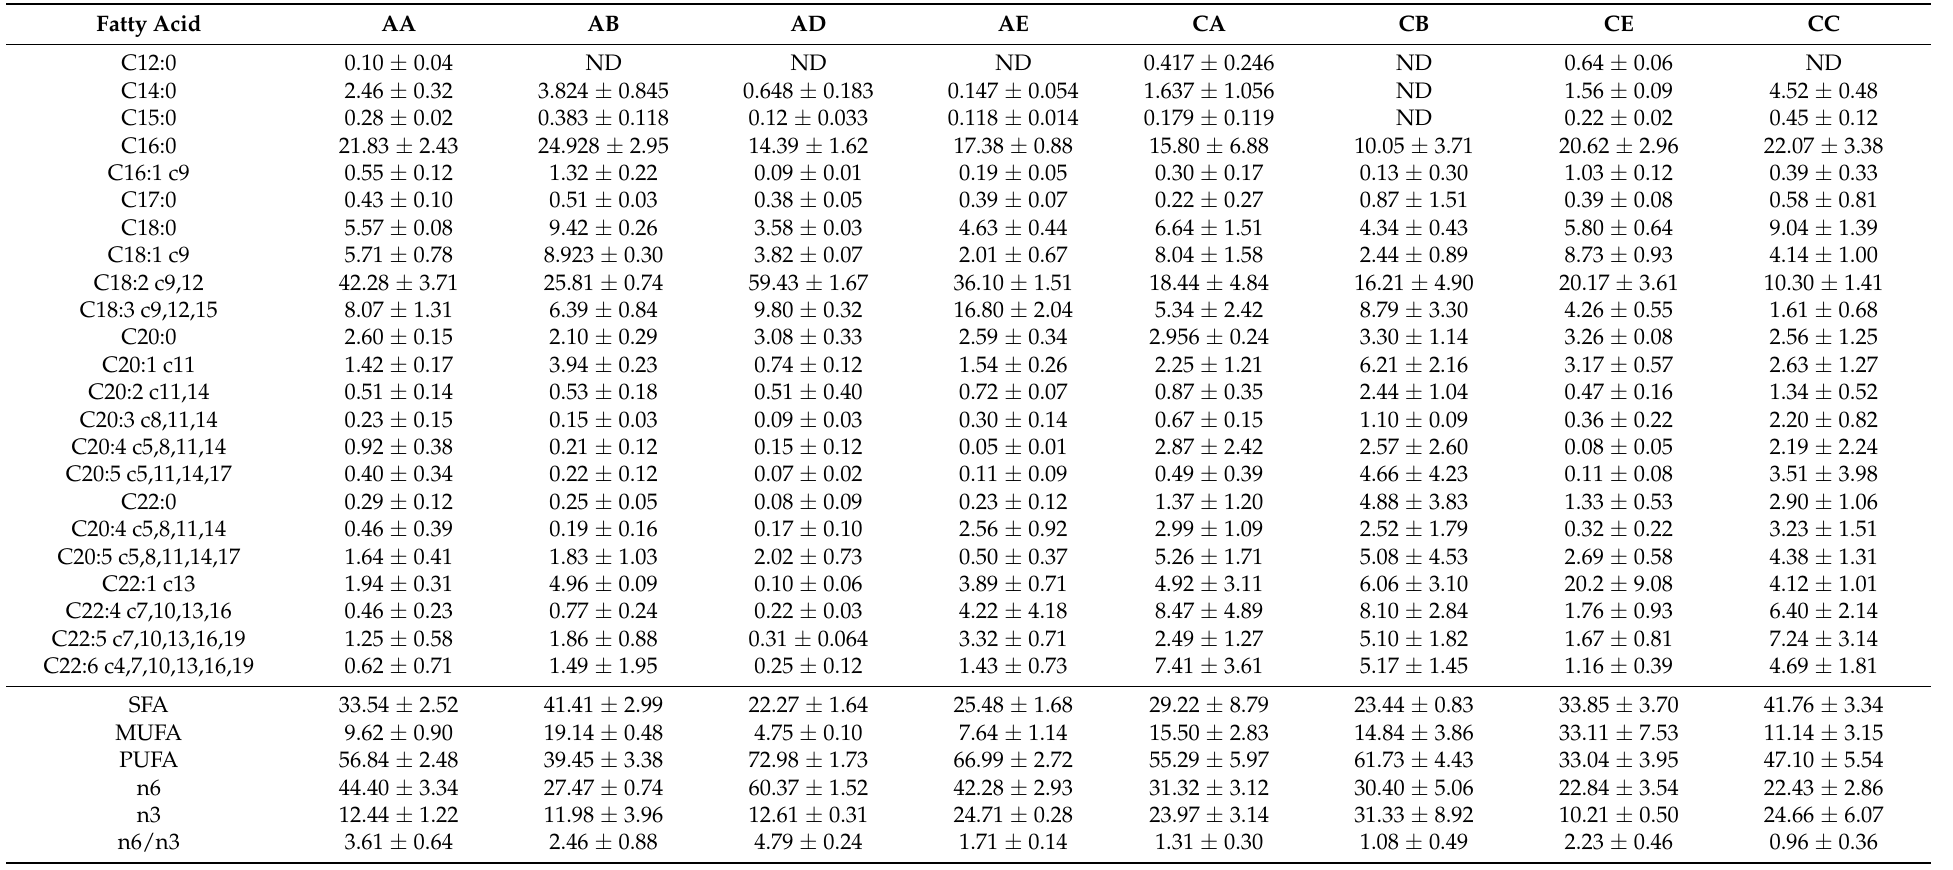
Table 3. The fatty acid profile obtained of the polar lipid extracts of the apple juice and apple cider samples expressed as the percentage of each fatty acid in the total fatty acids for each sample (mean ± SD, n =